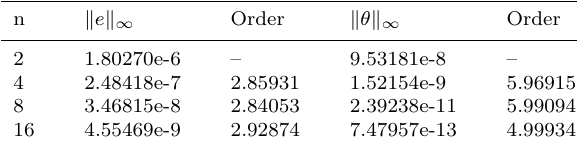
Table 8. Numerical results for example